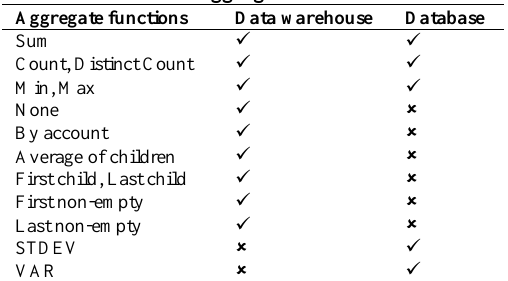
Table 2. Aggregate